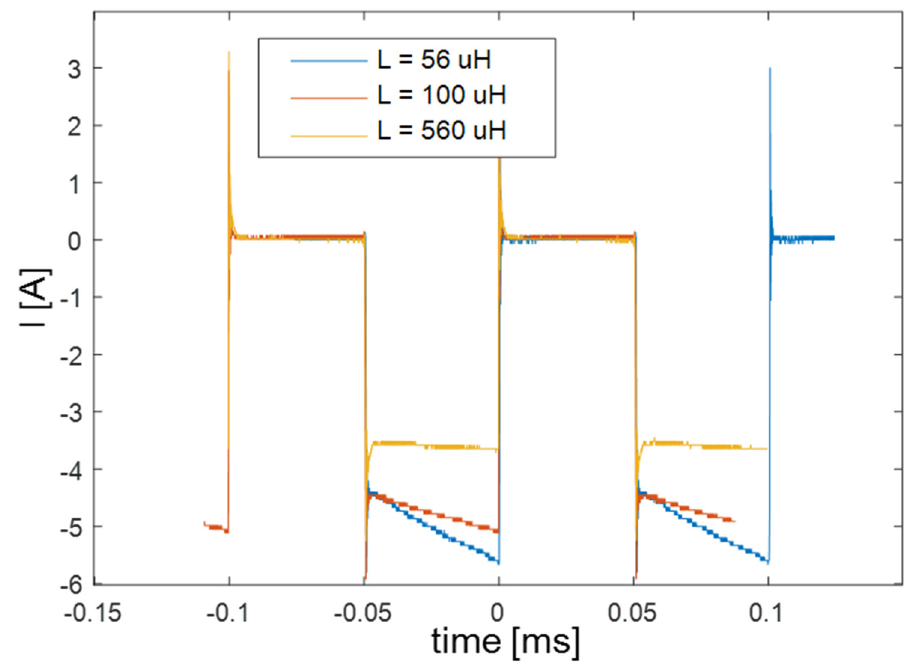
Figure 3. Current measurement during switching at 10 kHz with an inductor of 56, 100 and 560 µH.